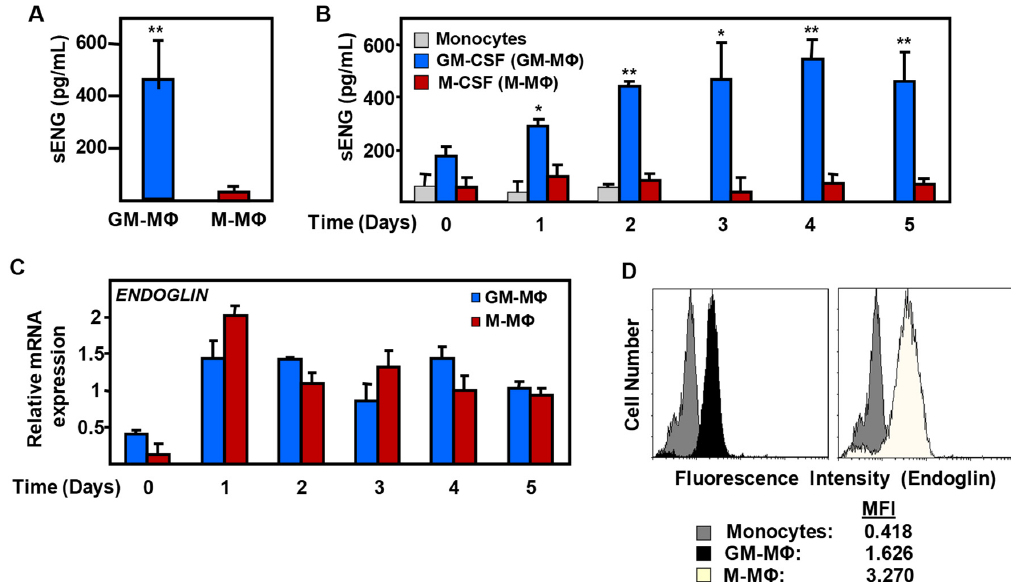
Figure 4. Endoglin expression in GM-M Φ and M-M Φ . Human monocytes were incubated with GM-CSF or M-CSF, resulting in GM-M Φ and M-M Φ , respectively. Soluble endoglin (sEng) levels were measured by ELISA in culture supernatants at the final stage of di ff erentiation ( A ) or during a kinetic study ( B ). In panel B , the statistical significance with respect to the control sample (day 0) is indicated. ( C ) Comparative mRNA expression levels of endoglin along GM-M Φ and M-M Φ polarization, as determined by qRT-PCR. ( D ) Endoglin protein levels at the surface of GM-M Φ and M-M Φ were detected by immunofluorescence flow cytometry using a mouse monoclonal antibody directed against human endoglin. Values of mean fluorescence intensity (MFI) are indicated. Statistical analysis was calculated using the paired two-tailed Student t test ( n = 3), and data are presented as mean ± SD. (* p < 0.05; ** p <